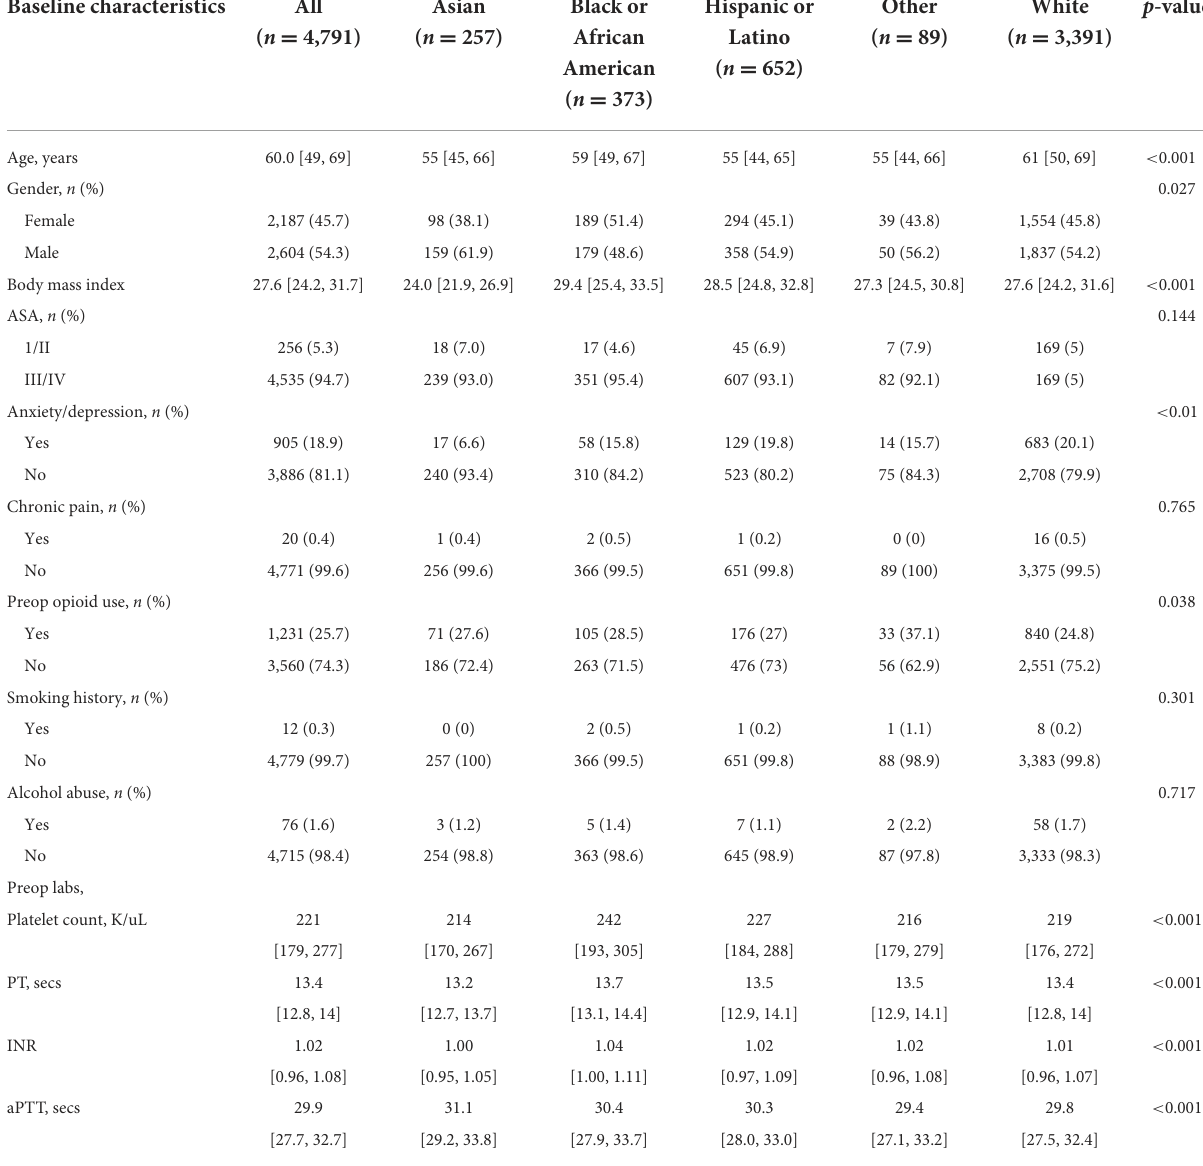
TABLE 1 Demographic and baseline characteristics of 4,791 adults undergoing open abdominal surgery. Baseline